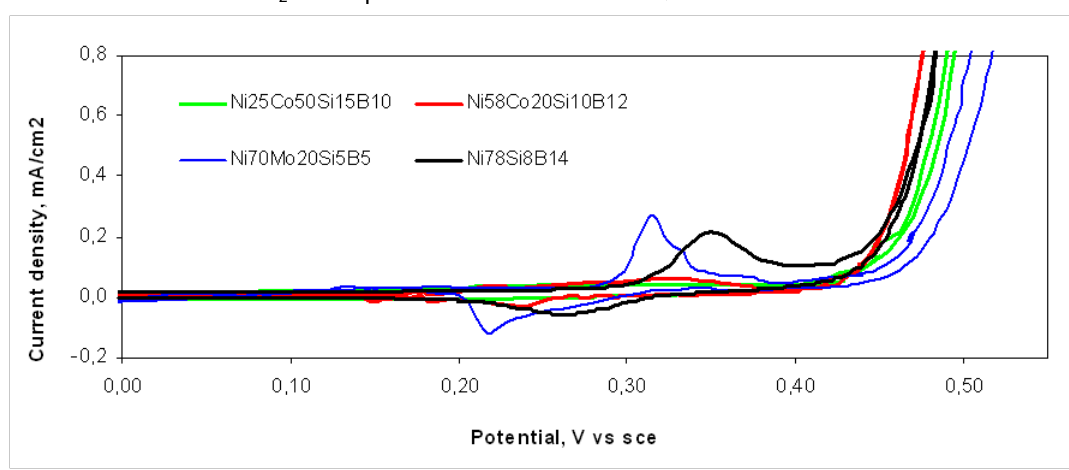
Figure 3. Cyclic voltammogram curves for four different Ni-containing metallic glasses in 1 M KOH at 25 ○ C in N atmosphere. Scan rate: 5.0 2